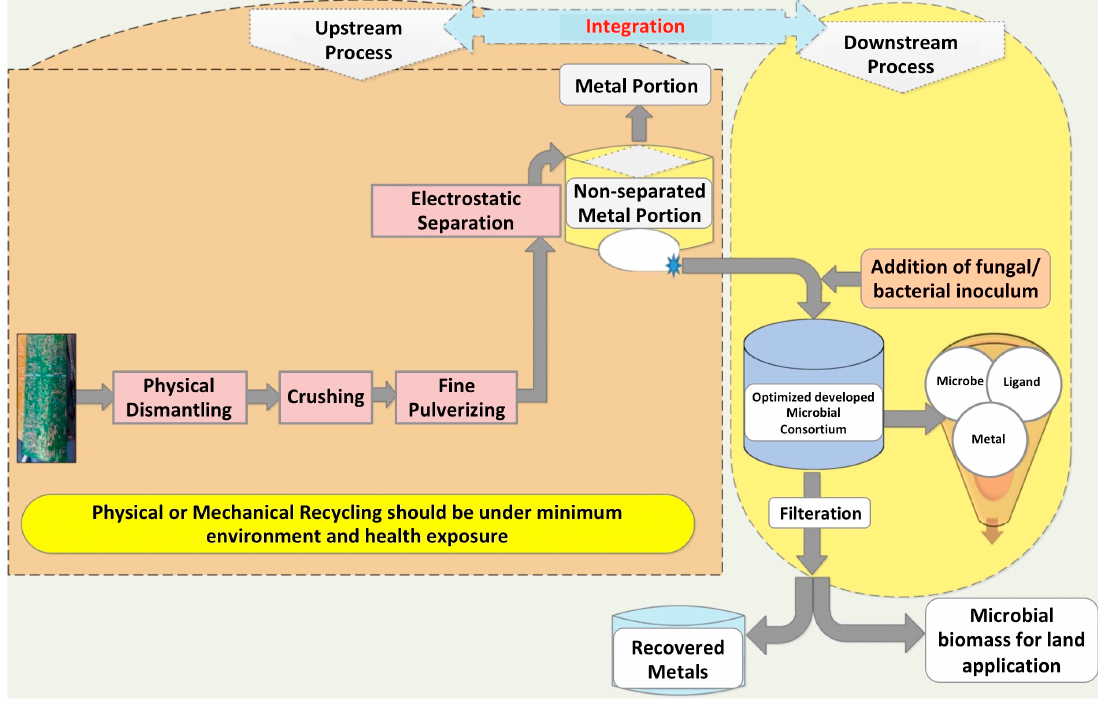
Figure 7. Illustration of integrated approach for copper recovery and recycling of WPCBs [225].